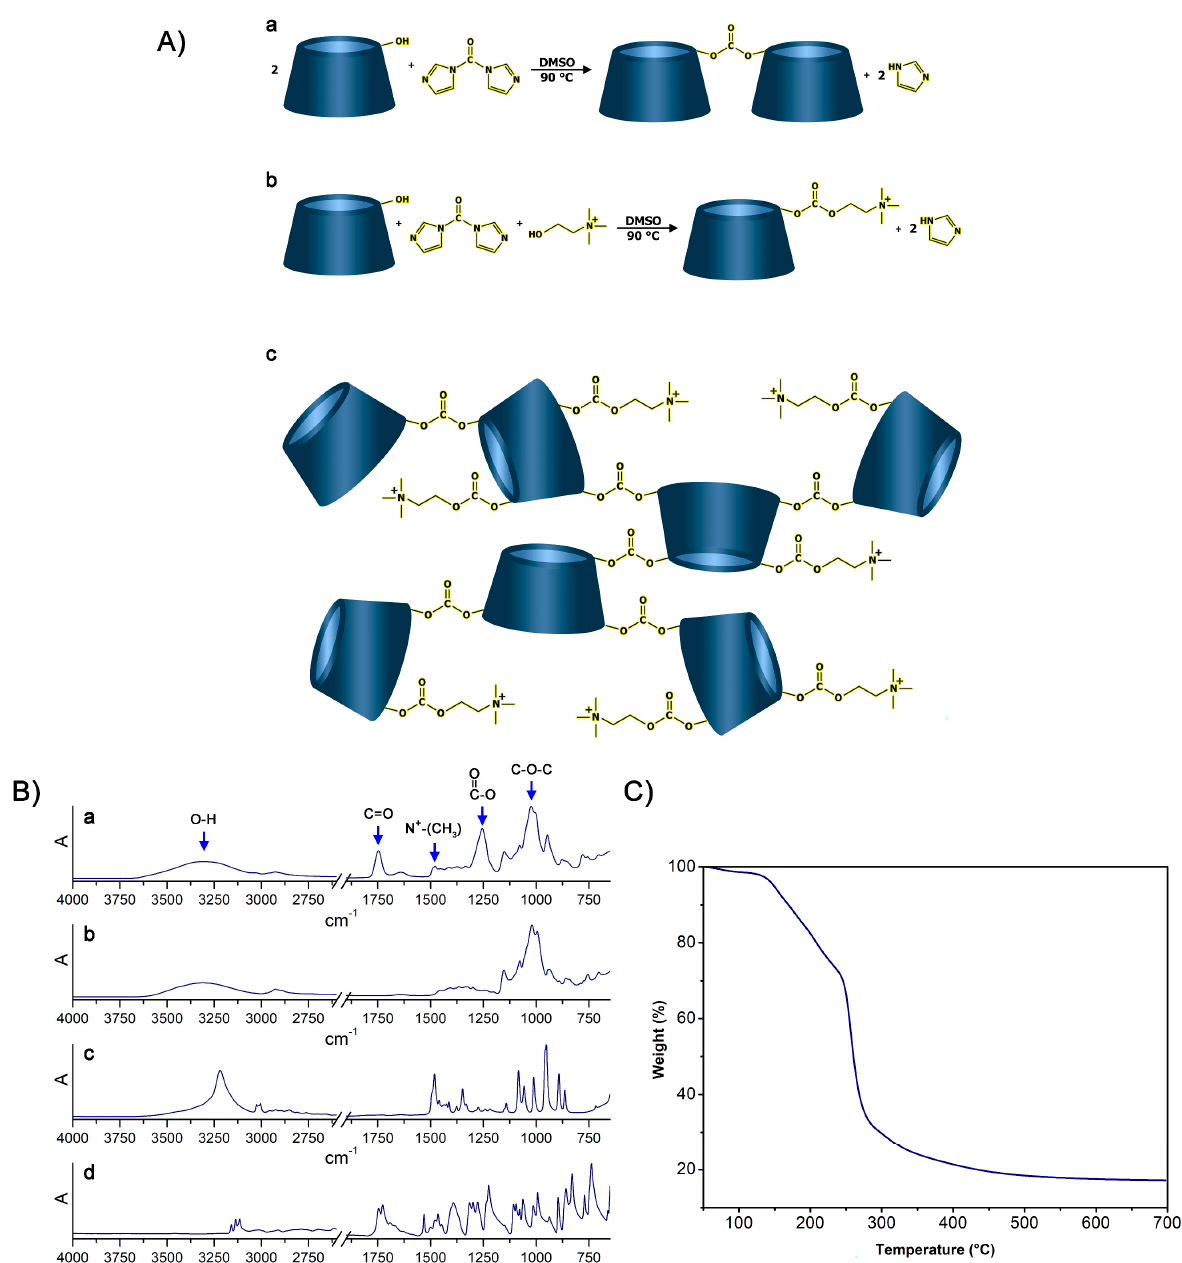
Figure 1. ( A ): ( a ) Reaction occurring between β CD and CDI, ( b ) reaction occurring between β CD, CDI, and CHO, ( c ) structure of the resulting hyper-branched polymer. ( B ): FTIR-ATR spectra of ( a ) PPoly, ( b ) β CD, ( c ) CHO, and ( d ) CDI. ( C ) TGA of PPoly.